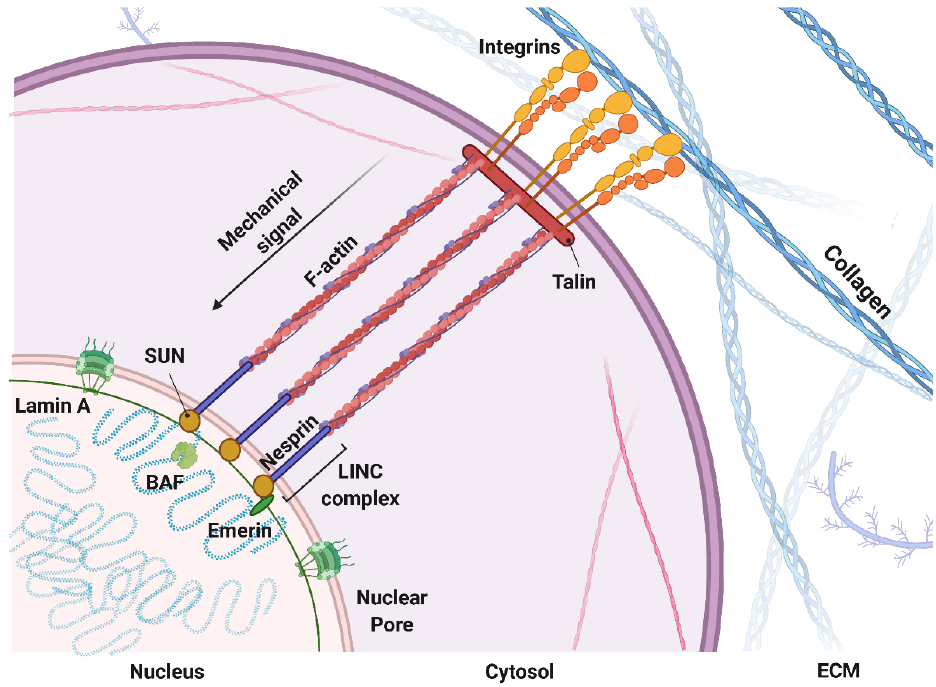
Figure 1. Mechanical coupling of the extracellular matrix with the nucleus: mechanical signal prop- agation through molecular pathways inside the cytosol and nucleus. Made with